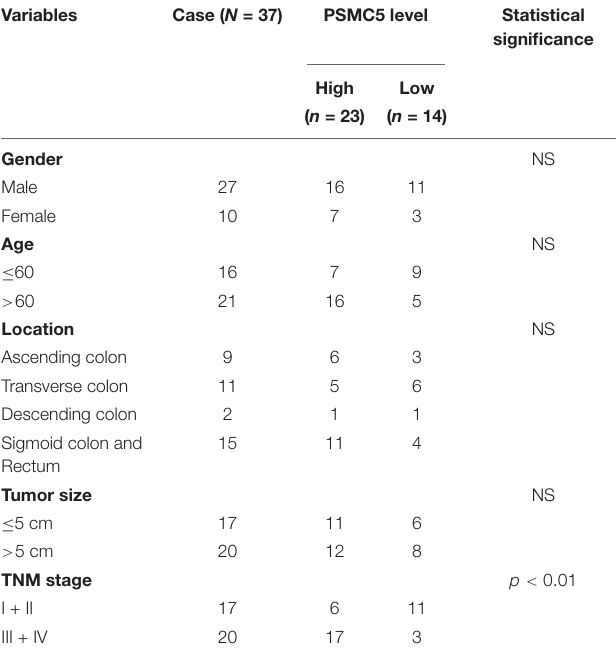
TABLE 1 | Relation of PSMC5 and clinical-pathology